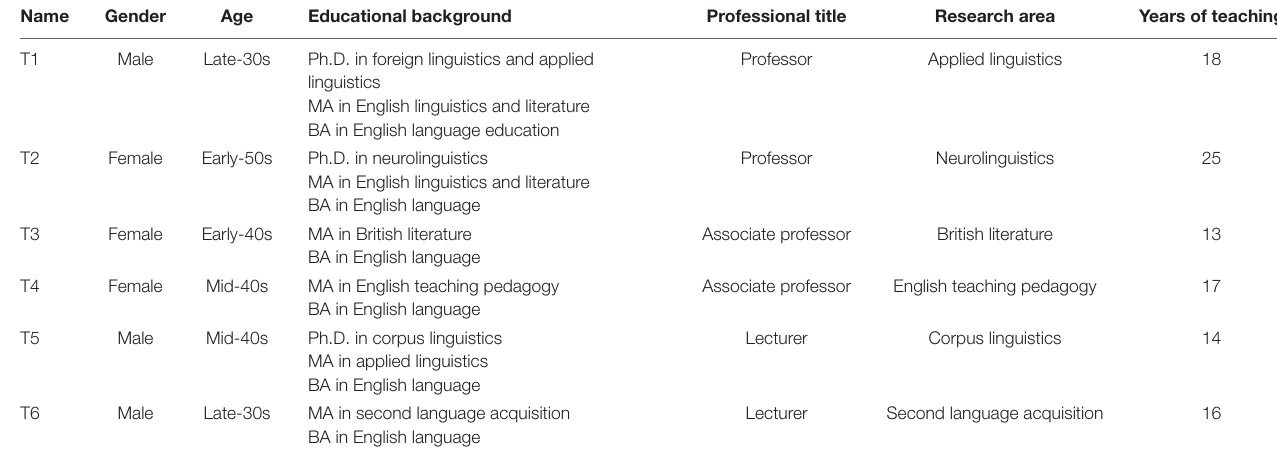
TABLE 1 | Background information of the